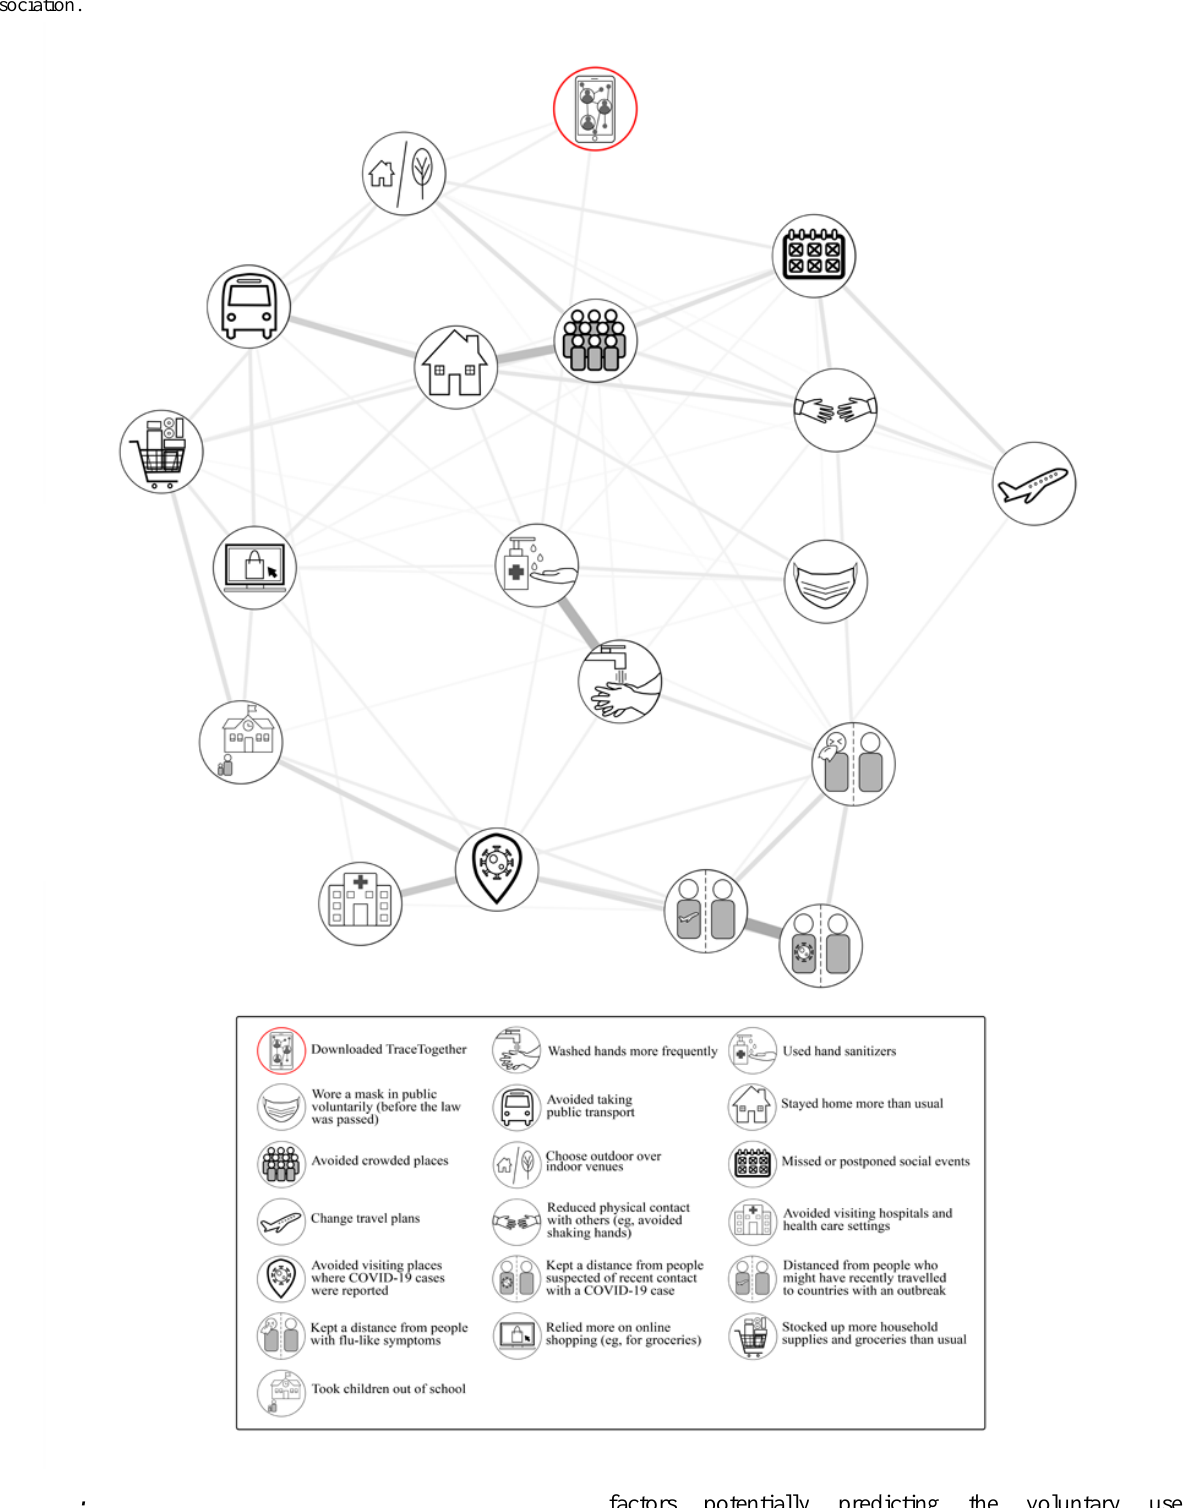
Figure 2. A model depicting how TraceTogether usage relates to other pandemic-related behavioral changes. Line thickness represents the strength of an